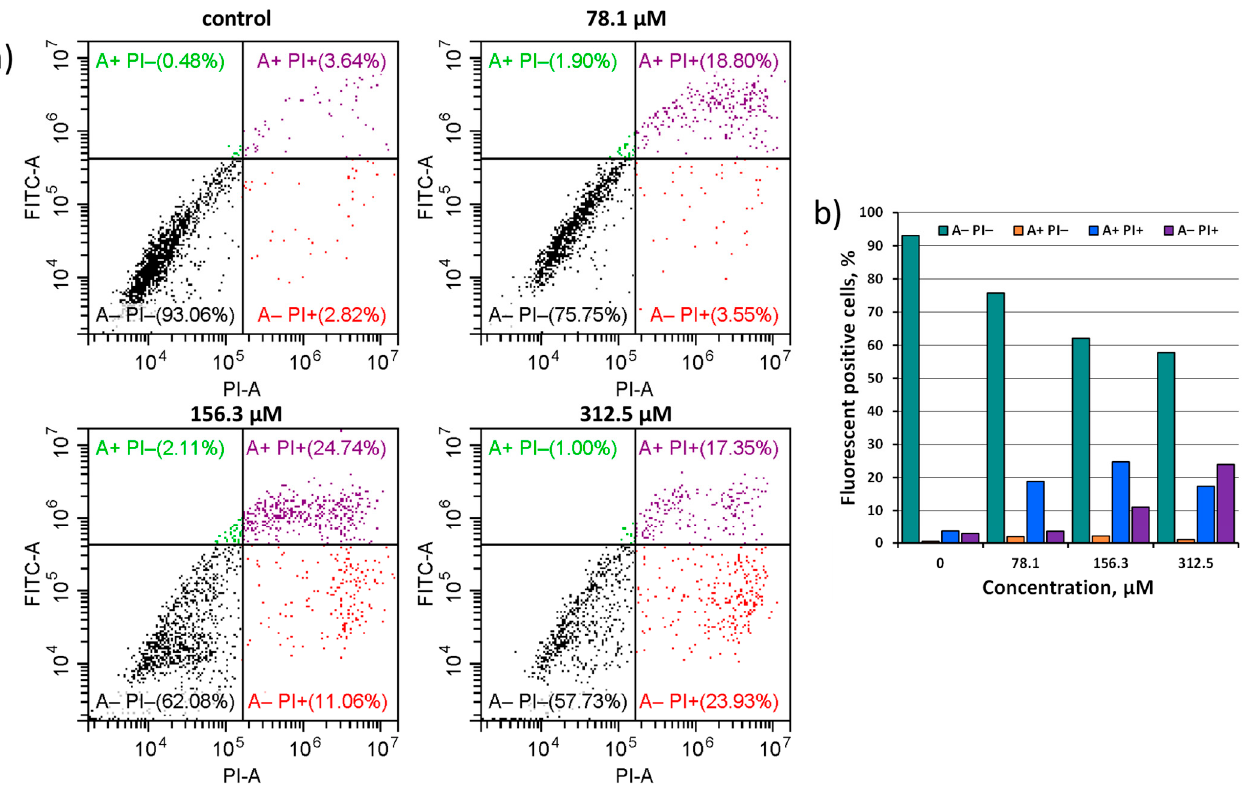
Figure 7. ( a ) Effect of Na 6 -2 on the apoptosis of Hep-2 cells. Cells were treated with 78.1, 156.3, or 312.5 μ M of Na 6 - 2 for 24 h, and then the cells were double-stained with FITC-Annexin V and PI and were exposed to a flow cytometry analysis. Dot plots show the distribution of early apoptotic (green A+ PI– square), late apoptotic (purple A+ PI+ square), and dead cells (red A– PI+ square). ( b ) A plot of fluorescent positive cells stained with dyes at different cluster concentration.